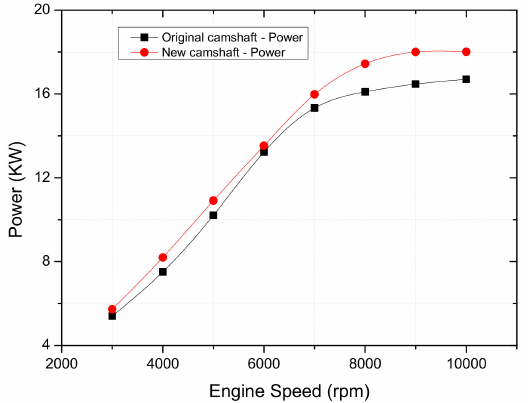
Figure 16. Comparison of engine power between the original and new valve